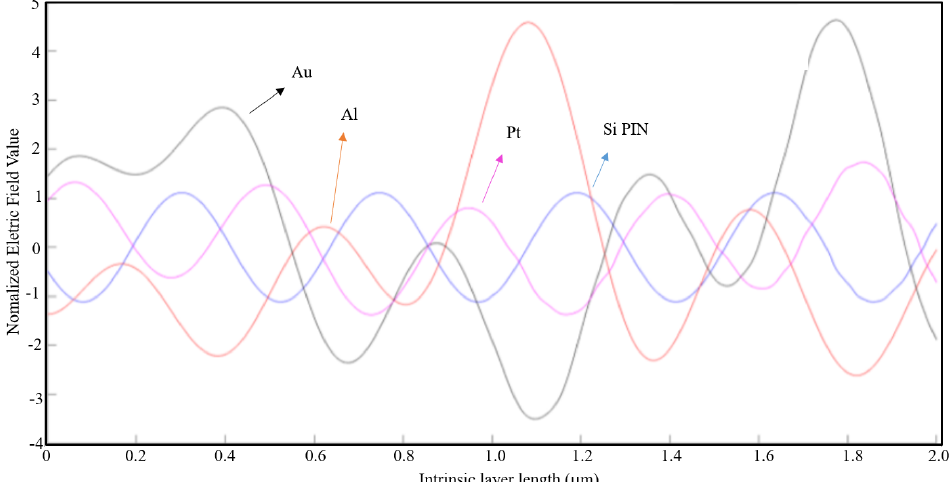
Figure 20. 1D Plot of the normalized electric field, z-component, along the intrinsic zone for different nanoantenna material types: Si PIN junction (blue), Al nanoantenna (red), Au nanoantenna (black), and Pt nanoantenna (magenta) (7-slit array; light wavelength: 1550 nm; metal thickness: λ /100; air slit width: λ /5).